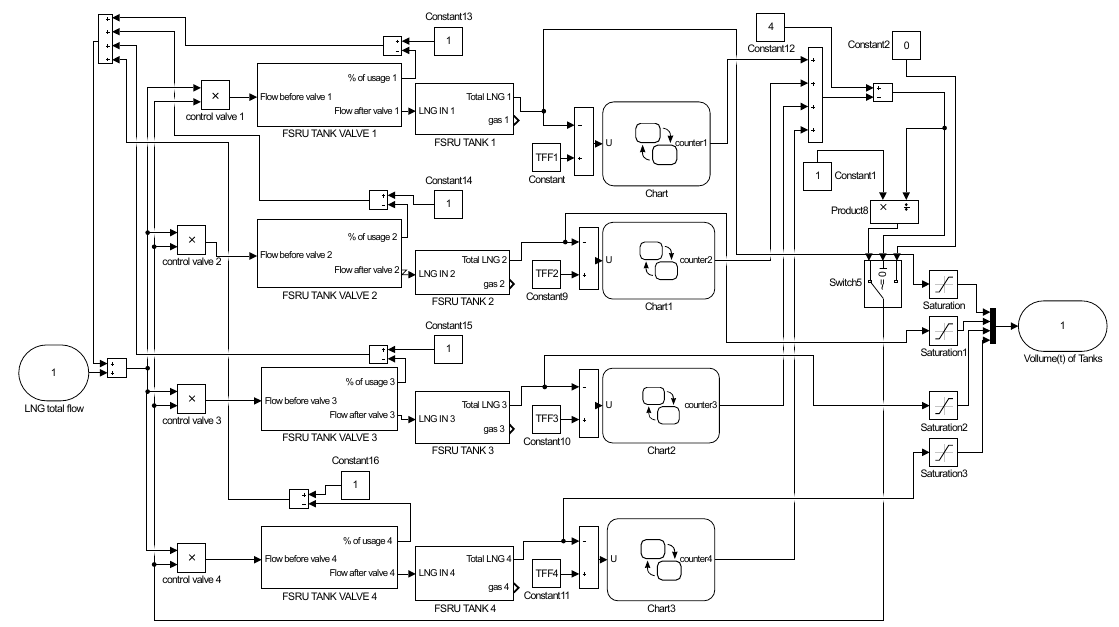
Figure 5. The FSRU subsystem modeled in Simulink.